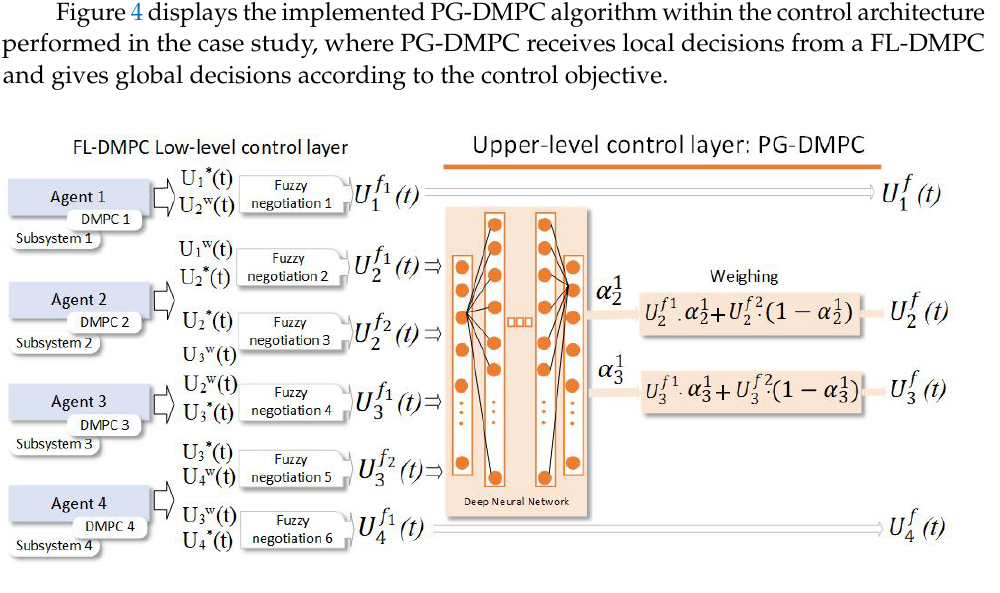
Figure 4. PG-DMPC negotiation algorithm